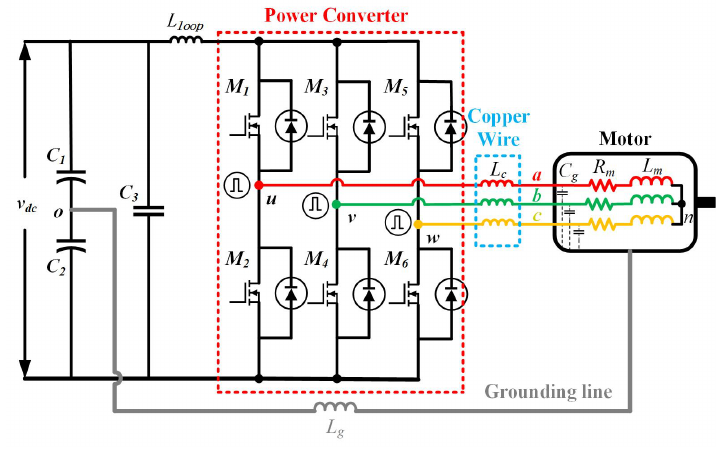
Figure 1. Scheme of a typical motor